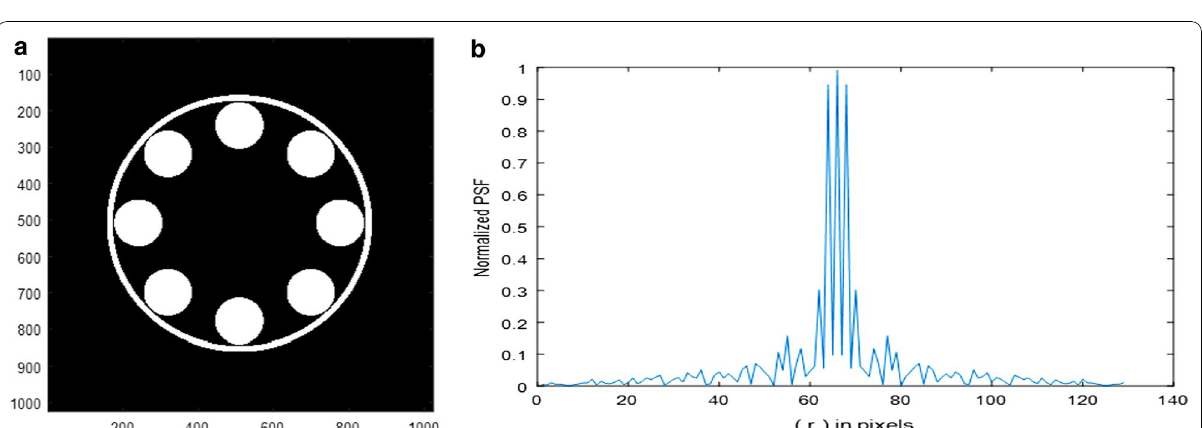
Fig. 5 a An aperture composed of eight equally spaced uniform circles surrounded by an annulus. The external radius of the whole aperture pixels, the annular width 16 pixels, and radius of each circle 64 pixels. The matrix of dimensions 1024 = = function of radial distance r (pixels) in the Fourier plane for a lens limited by the aperture shown in Figure